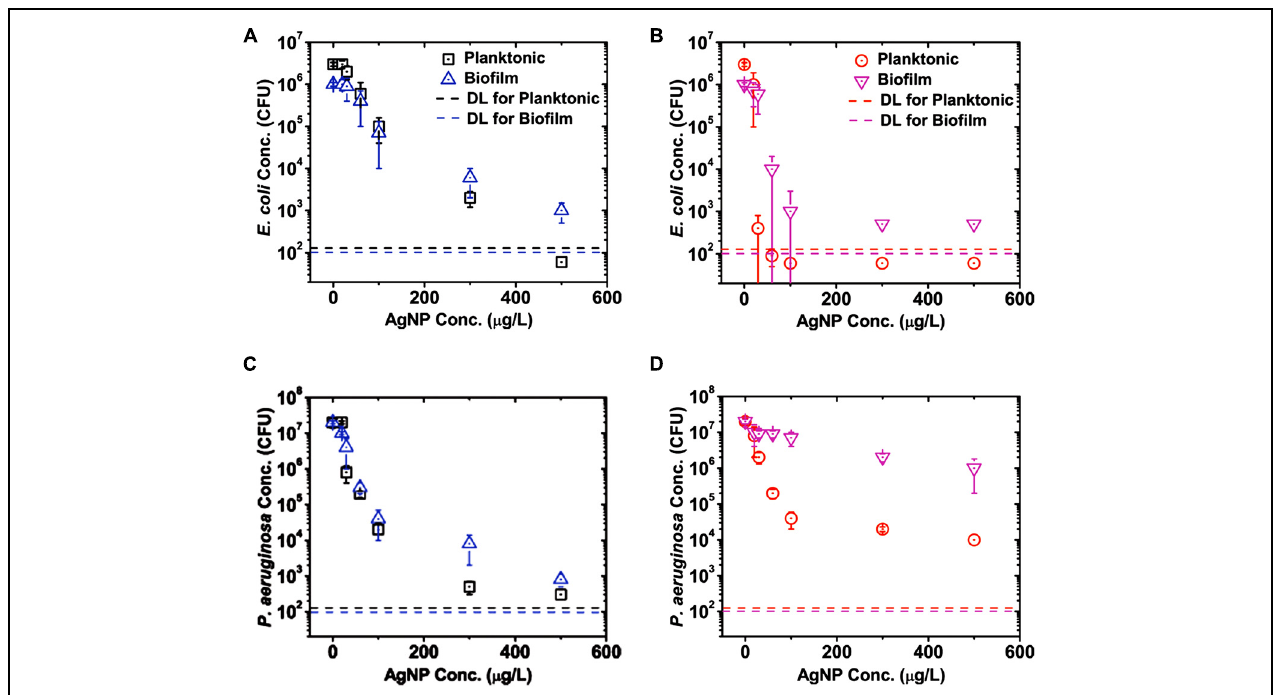
FIGURE 2 | Silver nanoparticle (AgNP) tolerance assays for planktonic and biofilm cells of Escherichia coli and Pseudomonas aeruginosa . (A) E. coli cells without previous exposure to AgNPs, (B) E. coli cells with previous exposure to 15.6 µ g/L AgNPs, (C) P. aeruginosa cells without previous exposure to AgNPs, (D) P. aeruginosa cells with previous exposure